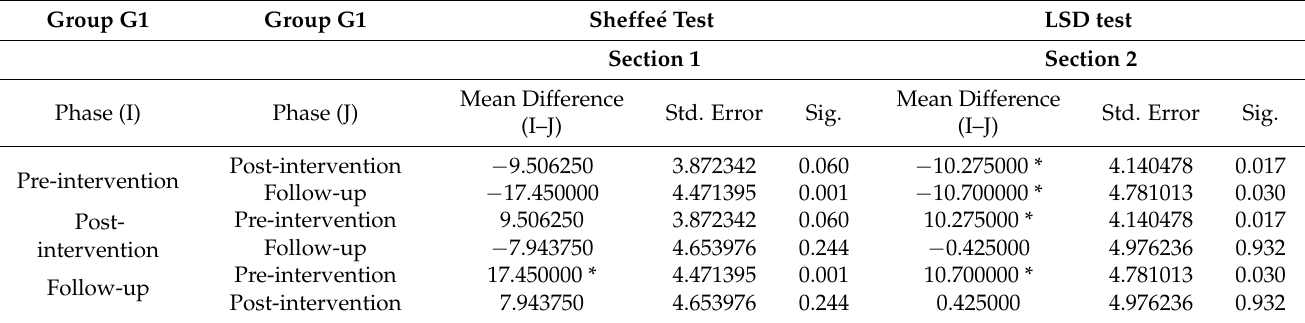
Table 4. Results of multiple comparison tests between phases of